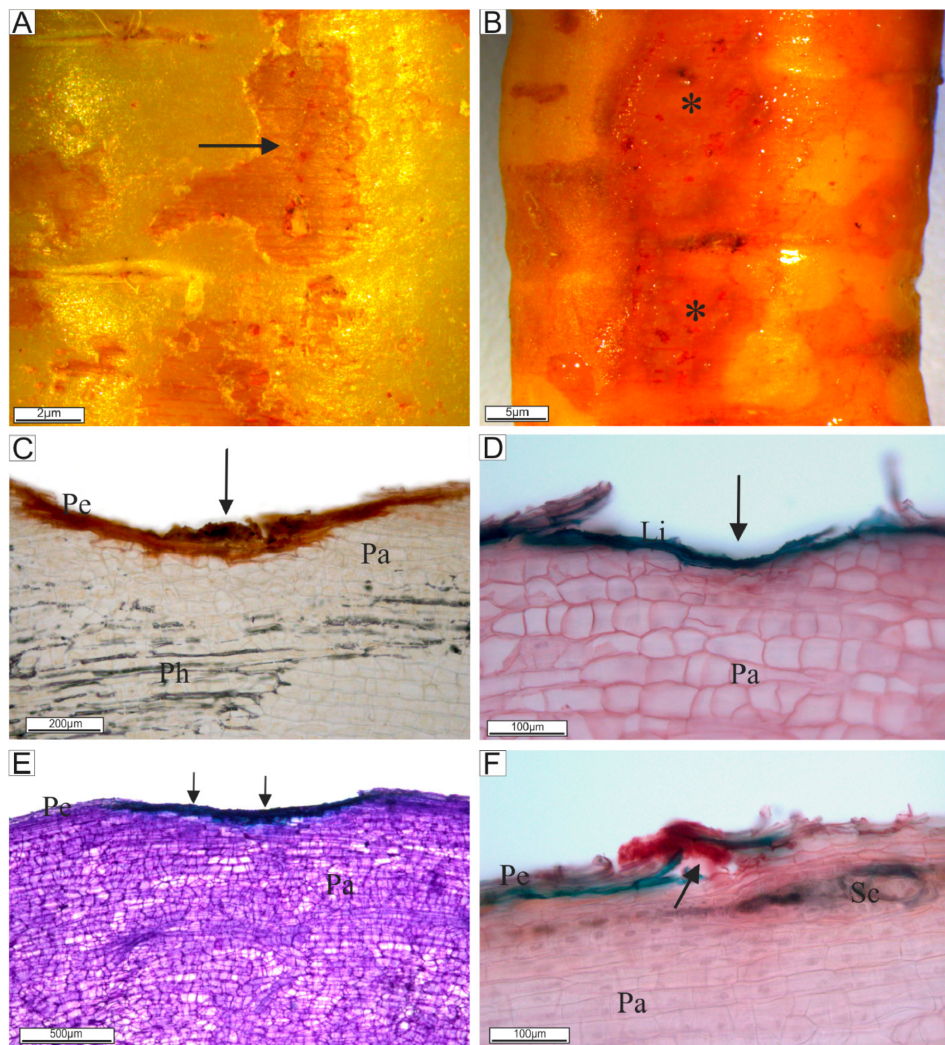
Figure 4. Damage to yellow carrots promoted by the carnauba wax: ( A ) Carnauba wax 6%; ( B ) carnauba wax 12%; ( C ) carnauba wax 6%; and ( D ) carnauba wax 12%. Photomicrographs of cross sections of superficial region of carrots: ( C ) Depression and compaction of the periderm. ( D ) Rupture and compaction of periderm cells evidenced by lignin deposition. ( E ) Compression of the periderm layers. ( F ) Periderm rupture near the secretory canal. Sc = Secretory canal; Ph = Phloem; Li = Lignin; Pa = Parenchyma; Pe = Periderm (arrows = depressions; * regions with viscous appearance).